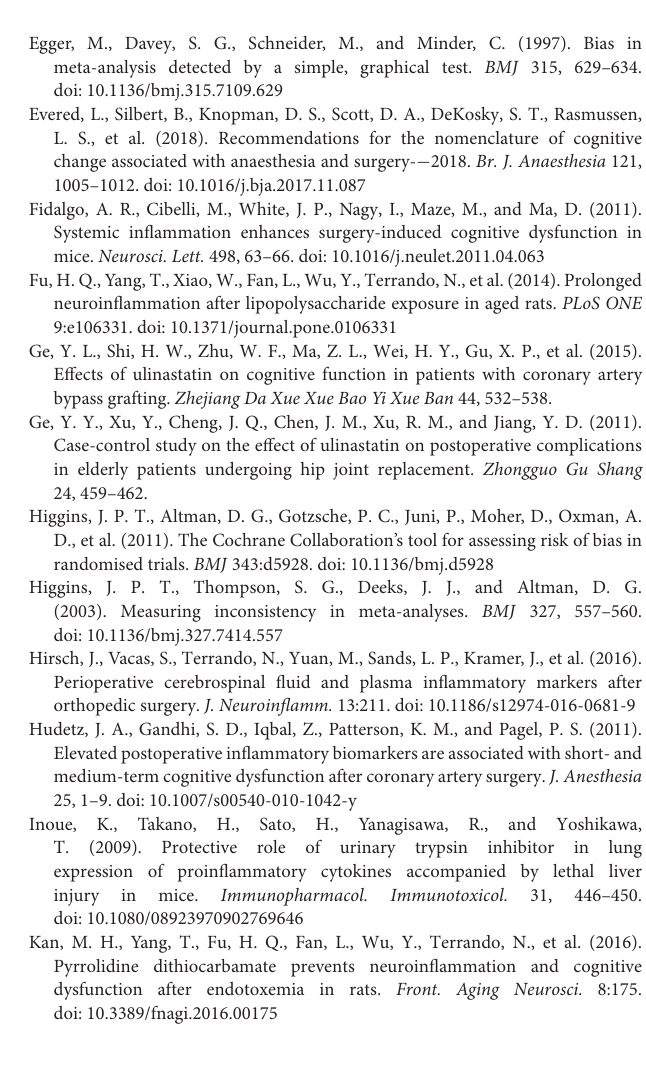
Supplementary File 1 | The search strategy formula about the Meta-Analysis. Supplementary File 2 | Sensitivity analysis graph: evaluating the stability of the effect of ulinastatin on POCD. Supplementary File 3 | Funnel plot about the incidence of POCD among included studies. Supplementary File 4 | Sensitivity analysis graph: evaluating the stability of the effect of ulinastatin on POCD after removing three articles with publication bias. Supplementary File 5 | Funnel plot about the incidence of POCD after removing three articles with publication bias. Supplementary File 6 | Funnel plot about the MMSE score among included studies. Supplementary File 7 | Changes in inflammatory factors reported by included